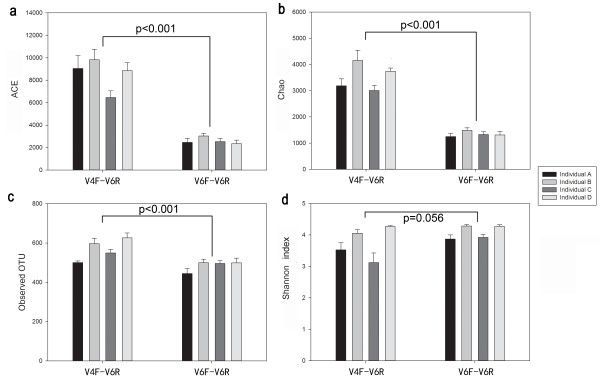
α-diversity comparisons between the two datasets. Mean values and 95% SEM are shown for each individual. Statistical analysis was performed using Mann-Whitney rank sum tests. Three species richness estimators, including (a) ACE (b) Chao and (c) number of OTUs, and one species evenness estimator, (d) Shannon’s diversity index, were included.